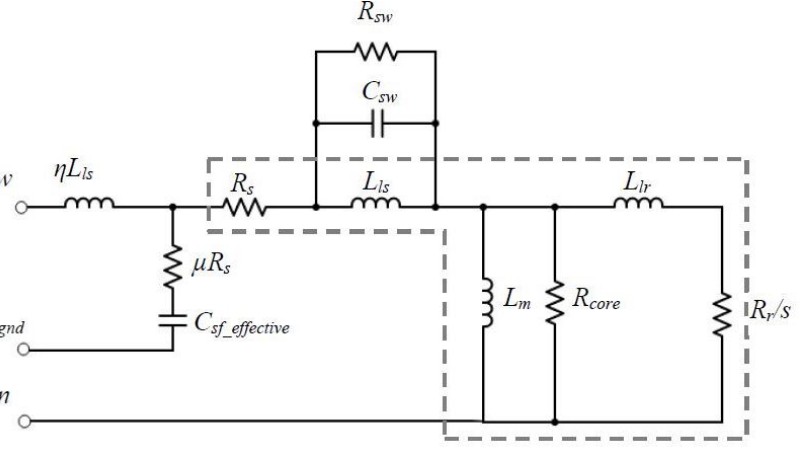
Figure 14. HF phase circuit proposed in